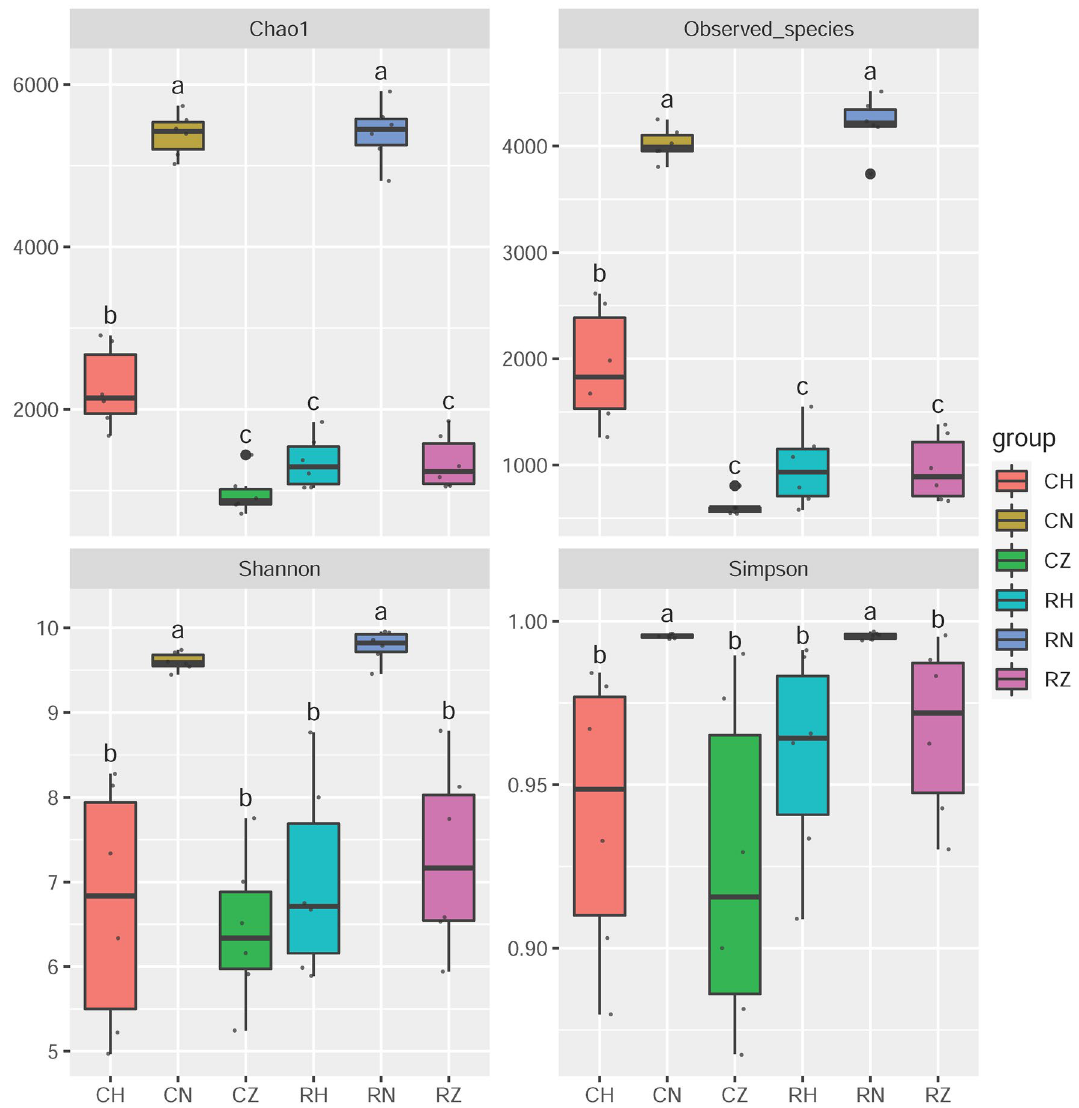
Figure 2. α-diversity analysis in all groups. Data with different letters at the column indicate significant differences ( P <